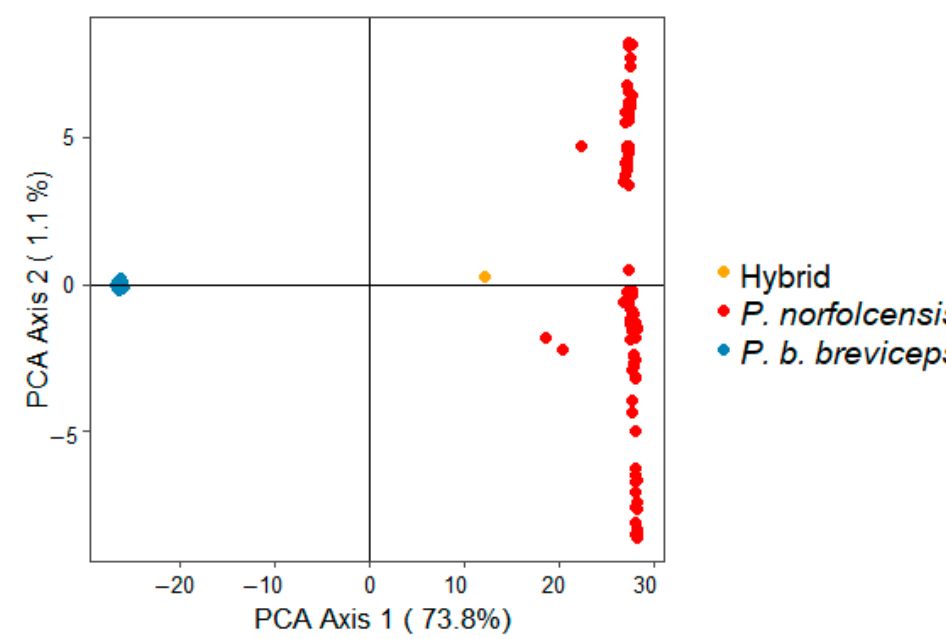
Figure 4. Principle coordinate analysis (PCoA) from genetic distances of 10,111 SNPs belonging to squirrel gliders ( P. norfolcensis , n = 87) and sugar gliders ( P. b. breviceps , n = 91). The potential hybrid individual ( P. b. breviceps × P. norfolcensis ) is coloured purple. Table 2. Pairwise FST of P. b. breviceps, P. norfolcensis , and potential hybrid (individual GMP24) are shown below the diagonal, while significance is shown above the diagonal. * = significant ( p < 0.05), NS = not significant ( p > 0.05).